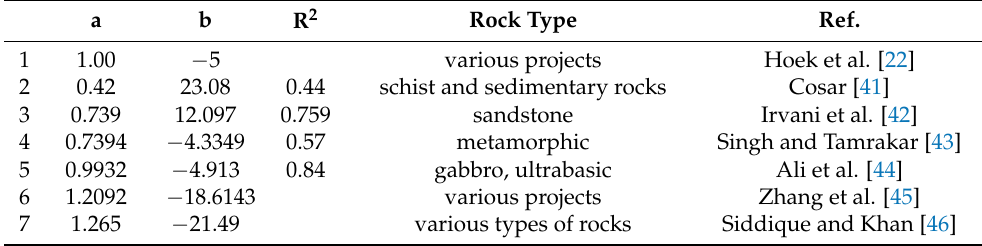
Table 1. Equations of the existing correlations between RMR 89 and GSI.